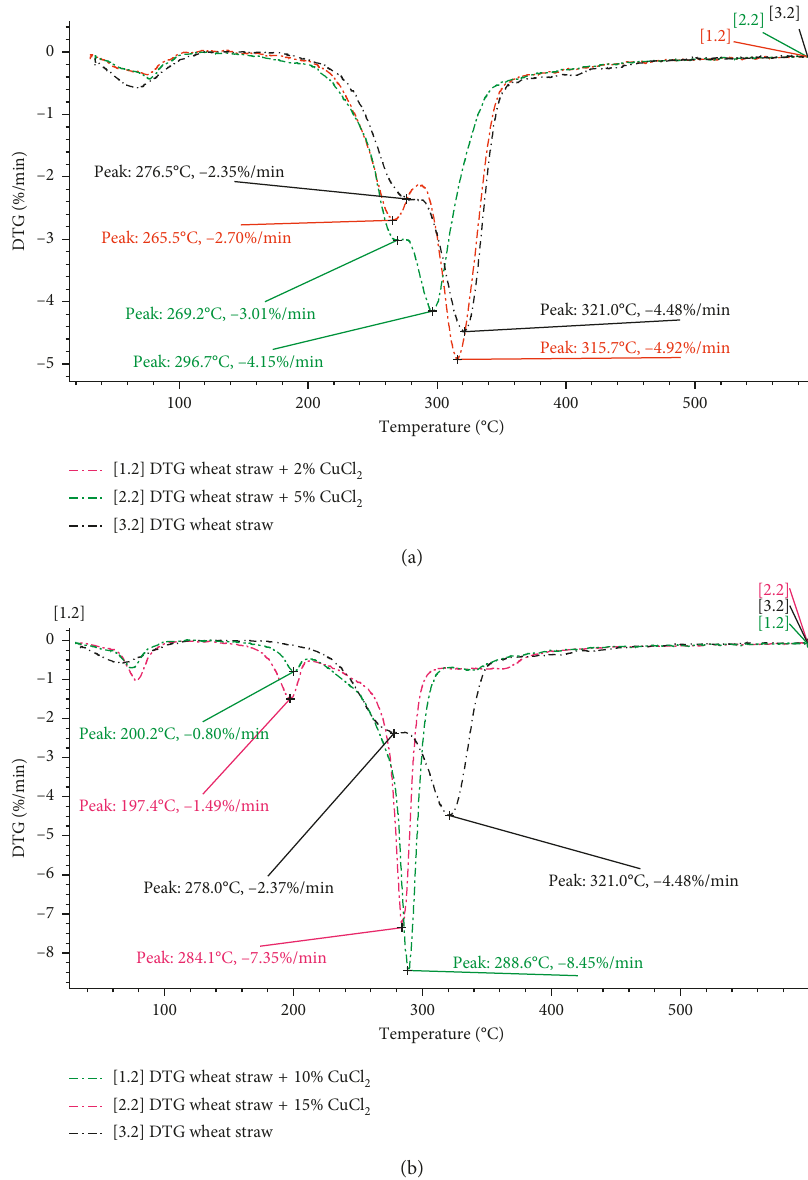
Figure 7: Thermogravimetric study of the CuCl 2 concentration effect on the wheat straw pyrolysis: (a) concentration range 2–5 wt.%; (b) concentration range